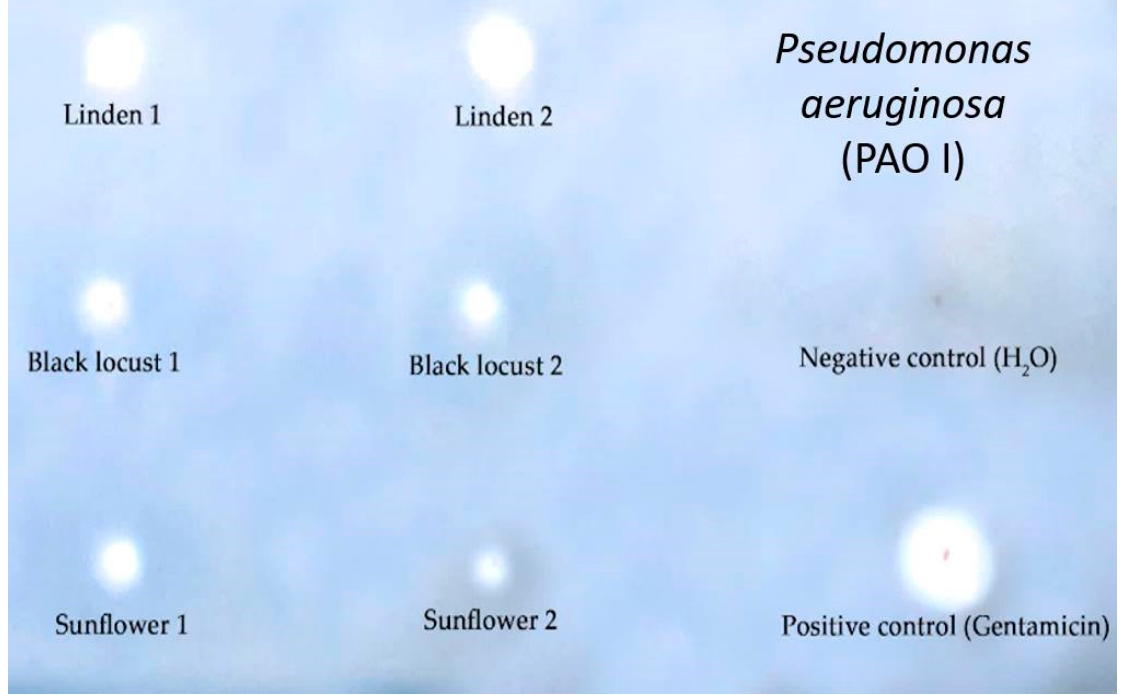
Figure 2. TLC–DB plate in the case of P. aeuruginosa . Negative control: distilled water, Positive control: gentamicin (40 mg/mL) from which 1.0 μ L was applied to the plate. The numbers after each honey type refer to Apiary 1 and Apiary 2. The stock solutions from honey samples were 1.0 g/mL, 1.0 µ L was applied to the plate. The blue background shows the viable bacteria. The white spots (as inhibition zones) indicated the lack of dehydrogenase activity due to the antibacterial activity of honey samples.